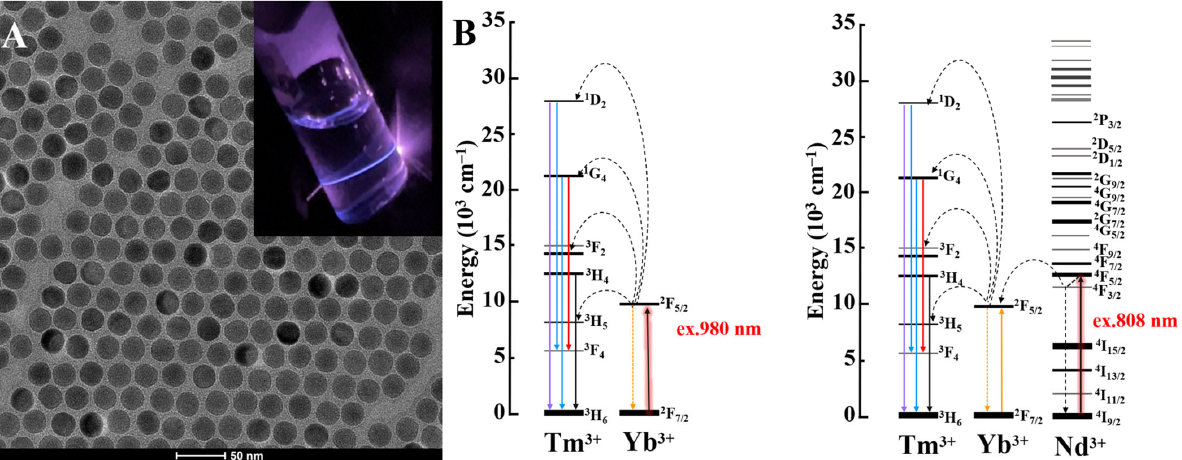
Figure 1. ( A ) Representative TEM image of NaYF 4 :Yb,Tm UCNPs (scale 50 nm) with digital inset of their UC emission under NIR laser. ( B ) Upconversion process of Tm 3+ activator under 980 nm and 808 nm excitation.